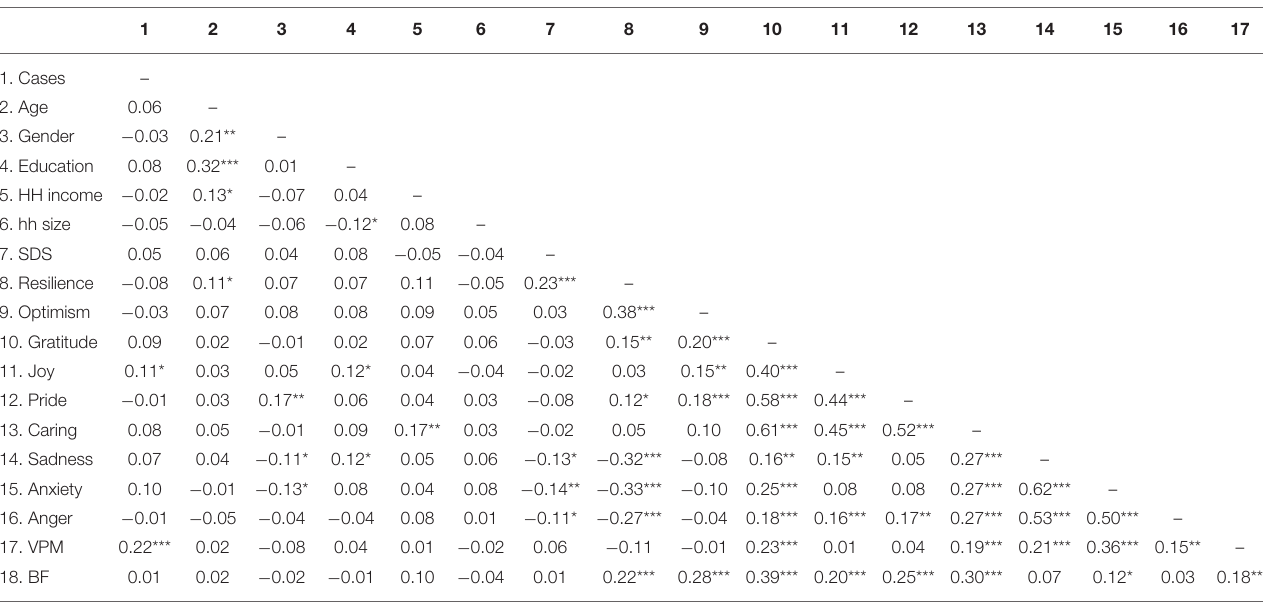
TABLE 2 | Correlation matrix for all key